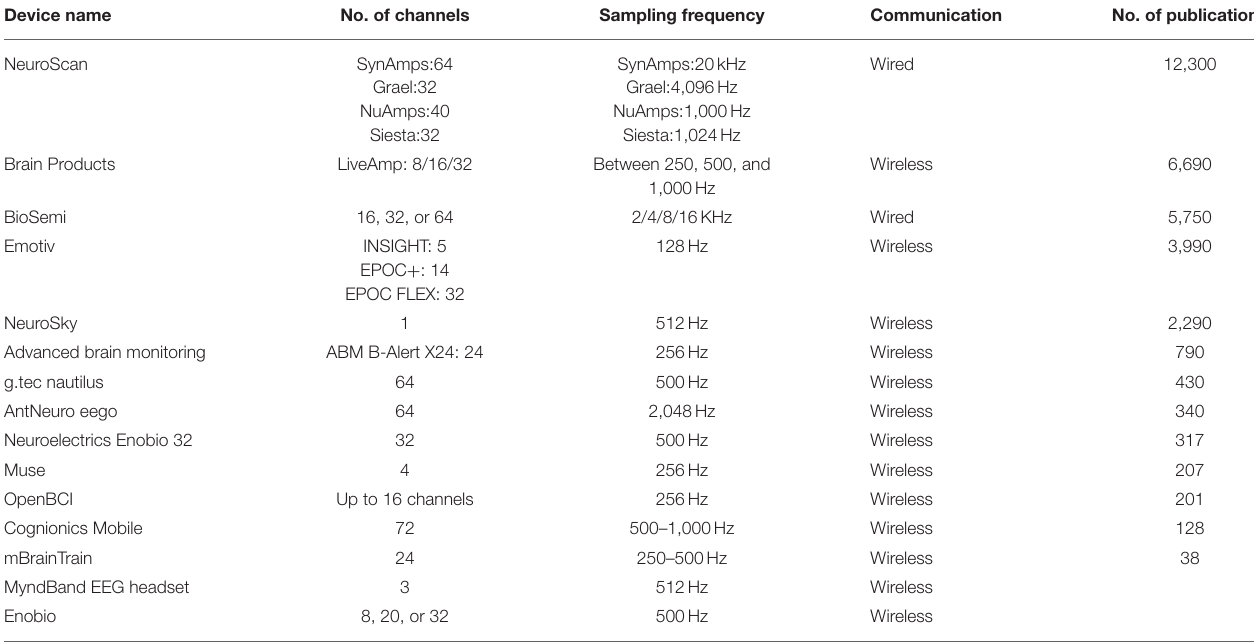
TABLE 2 | Summary table of recent EEG